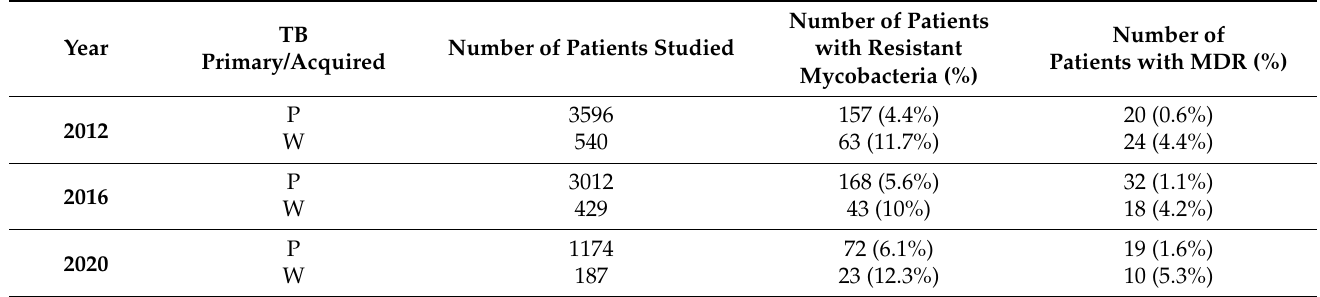
Table 7. Comparison of results in newly diagnosed and previously treated patients in Poland 2012, 2016, and